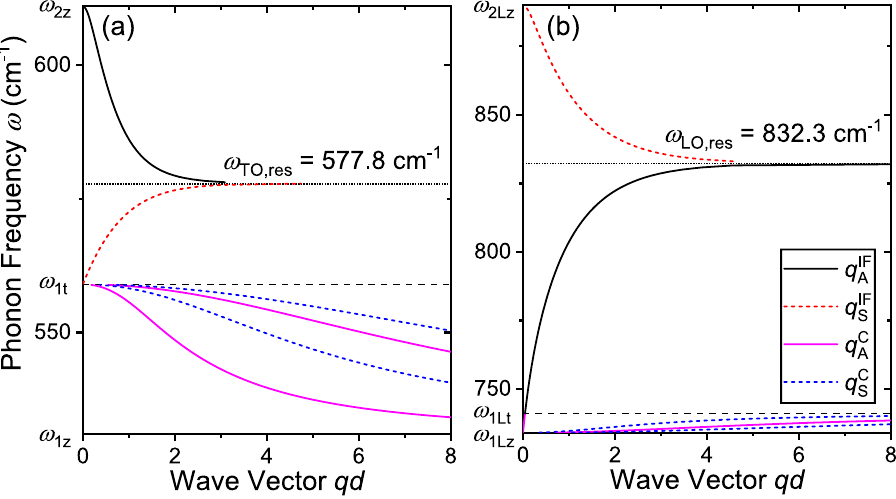
Figure 2. Dispersion relation of asymmetric interface ( q AIF ), symmetric interface ( q SIF ), asymmetric confined C ), and symmetric confined ( q C ) mode phonons of the AlN/GaN/AlN quantum well in the ( a ) low frequency ( q A S and ( b ) high frequency region are plotted. Only a few of the confined mode phonons (two modes each for the asymmetric and symmetric branch with lowest quantum numbers) are plotted. Phonon modes associated with TO phonon modes of AlN and GaN are shown in the ( a ) lower frequency region whereas those associated with LO phonon modes are in the ( b ) higher frequency region. The interface phonon resonant frequencies are shown in dotted horizontal lines and the other characteristic frequencies are shown in dashed horizontal lines. The x - axis is shown in the dimensionless wave vector qd